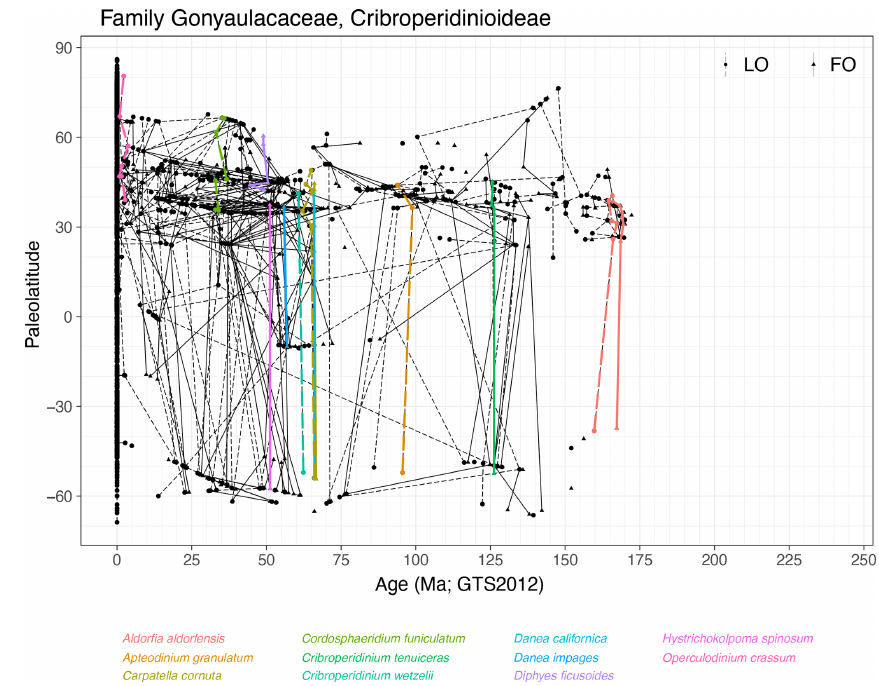
Figure 9. Same as Fig. 5 but for the family Gonyaulacaceae, subfamily Cribroperidinioideae.